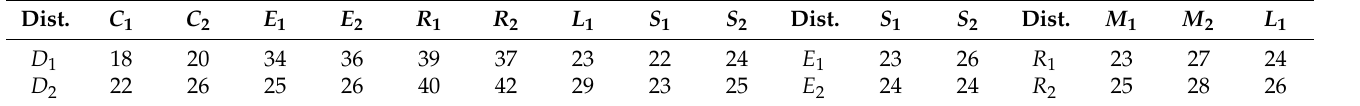
Table 6. Distance between centers (km).